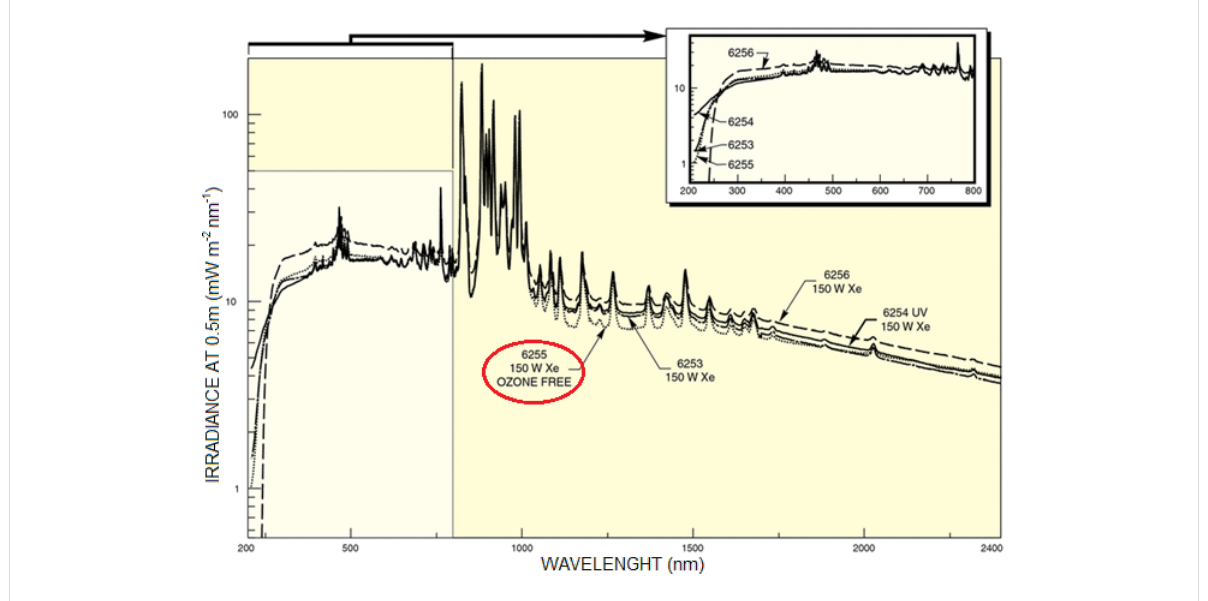
Figure 9: Typical spectra of a Xe arc lamp. The emission spectrum of the 150 W LSB521 Ozone-free Xe light source used in the experimental setup is highlighted.